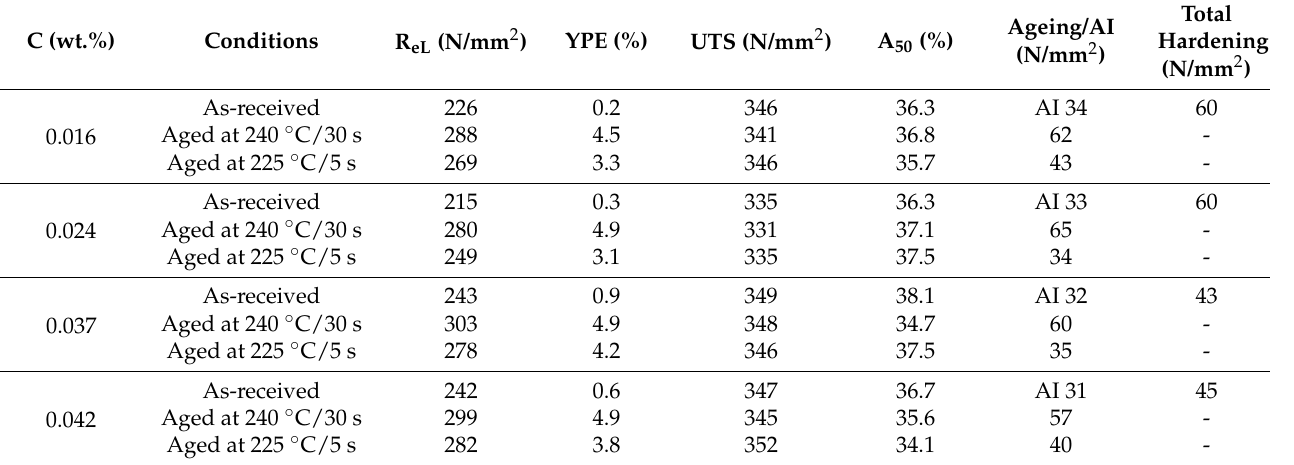
Table 2. Average tensile test results on samples with various C contents. C (wt.%)